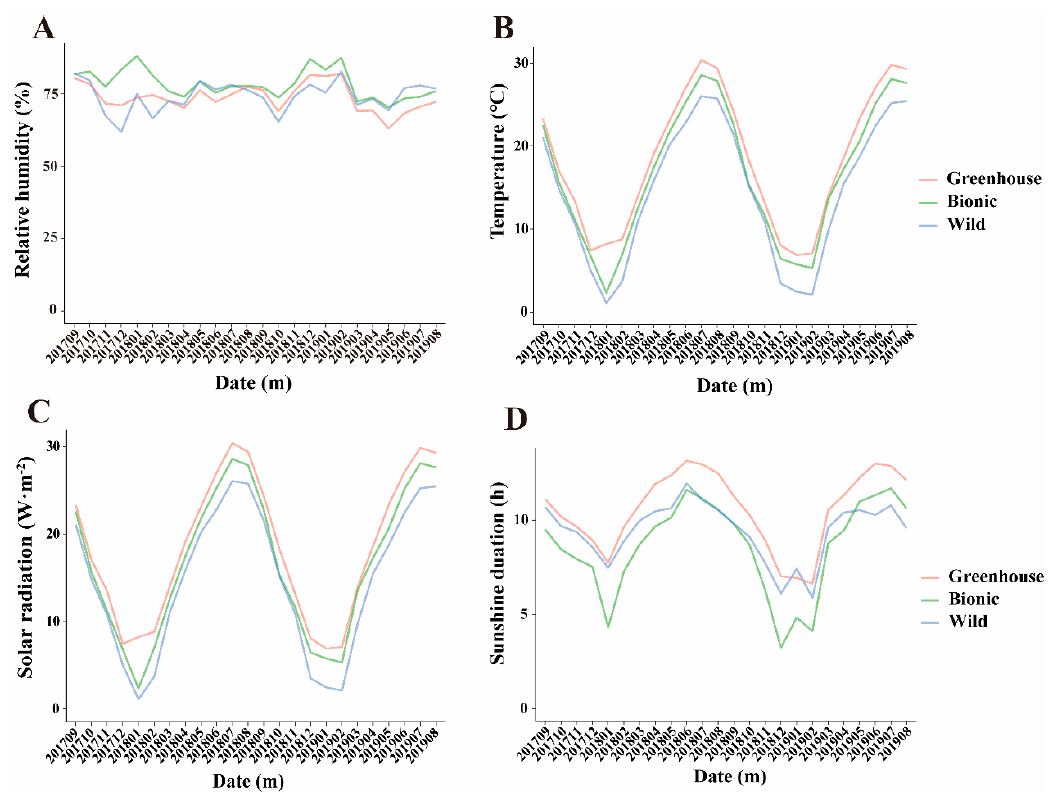
Figure 5. Monthly average line chart of four major climatic factors. The dates go from September 2017 to August 2019. ( A ) Relative humidity. ( B ) Temperature. ( C ) Solar radiation. ( D ) Sunshine duration.